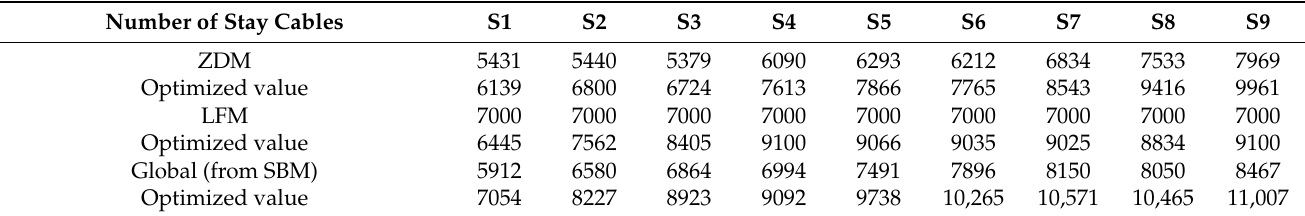
Table 3. Comparison of cable force values before and after optimization (unit: kN.m).